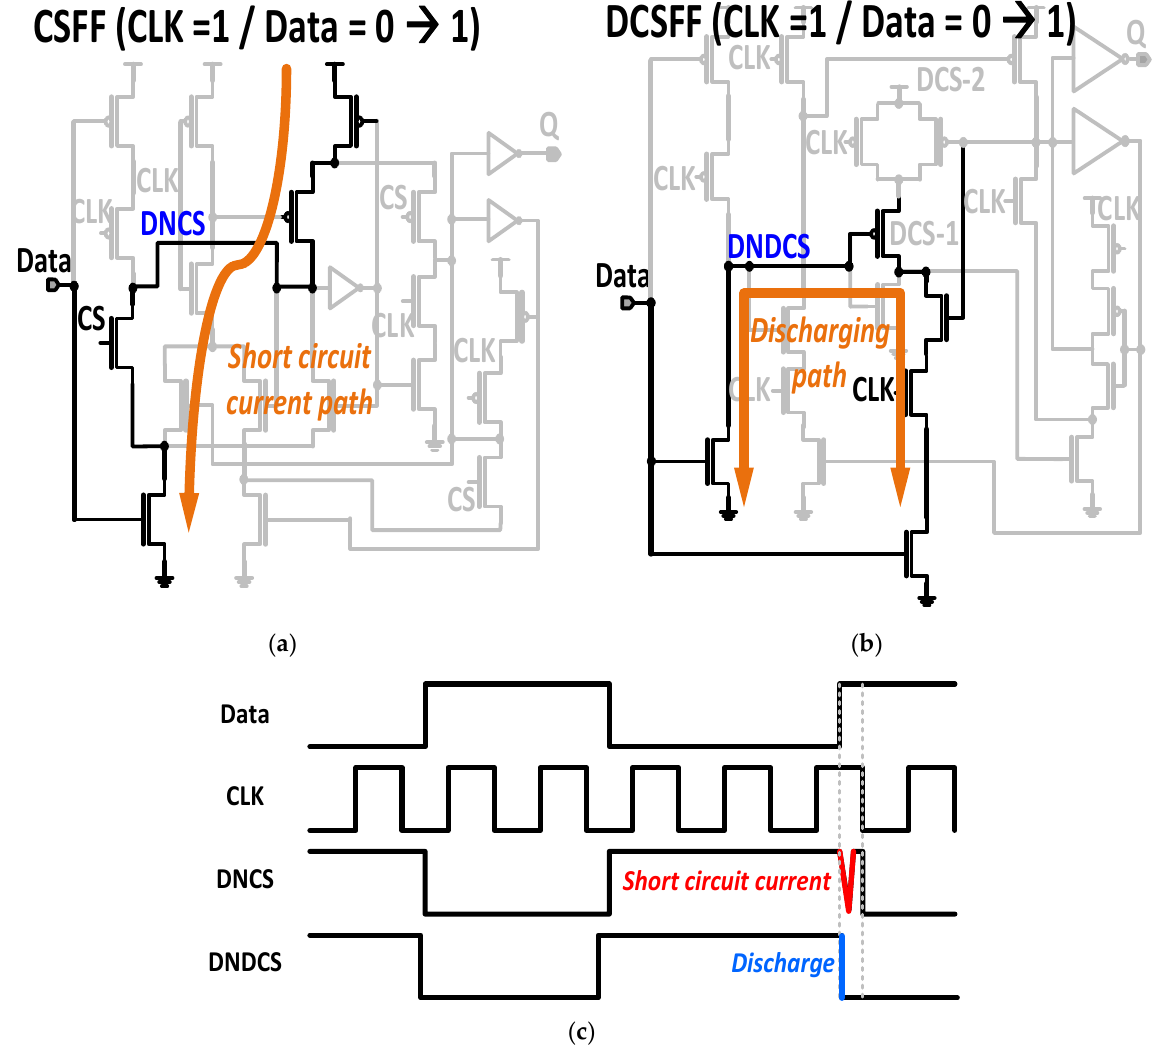
Figure 8. Circuit Diagram of ( a ) CSFF and ( b ) DCSFF and ( c ) Comparison of Timing Diagram.